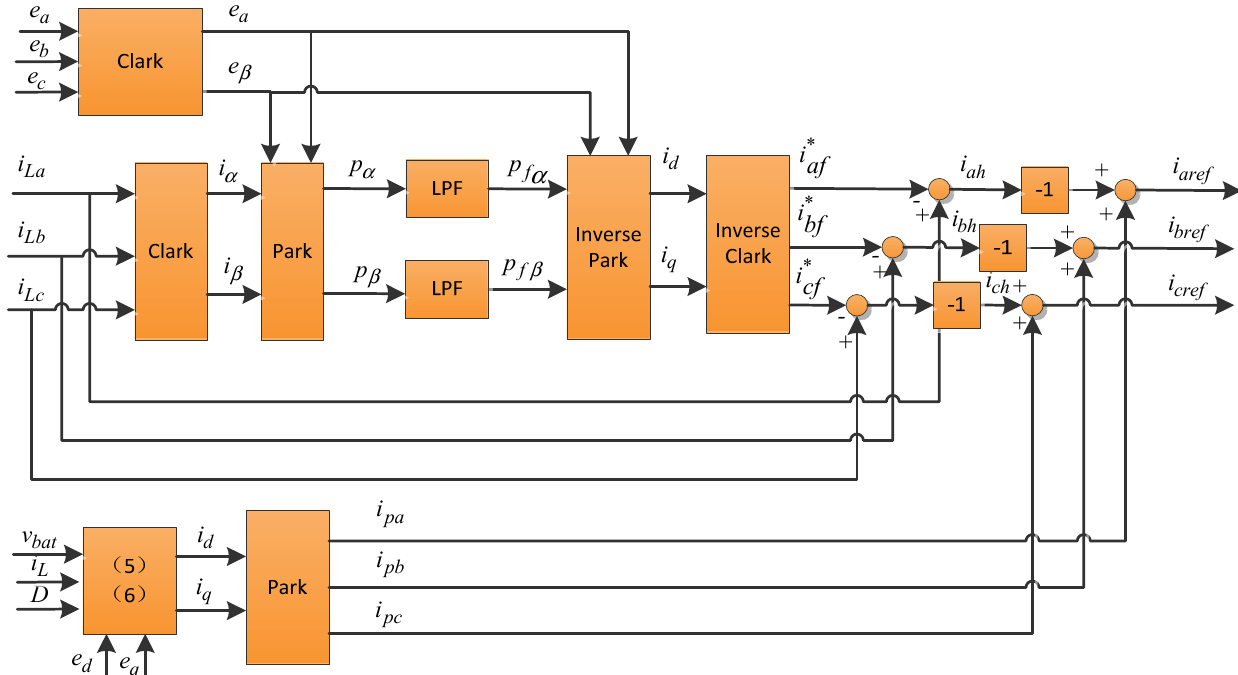
Figure 3. Block diagram of the proposed reactive compensation and harmonic suppression scheme. LPF: